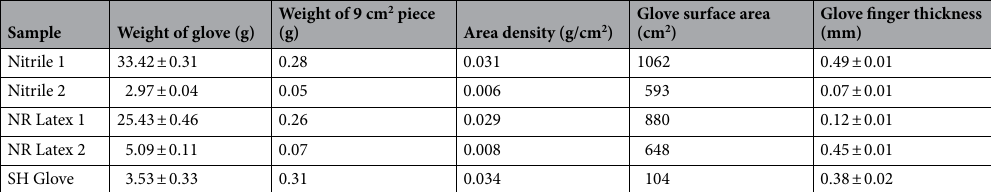
Table 1. Comparison table showing surface area, weight, and weight per unit area of different gloves.